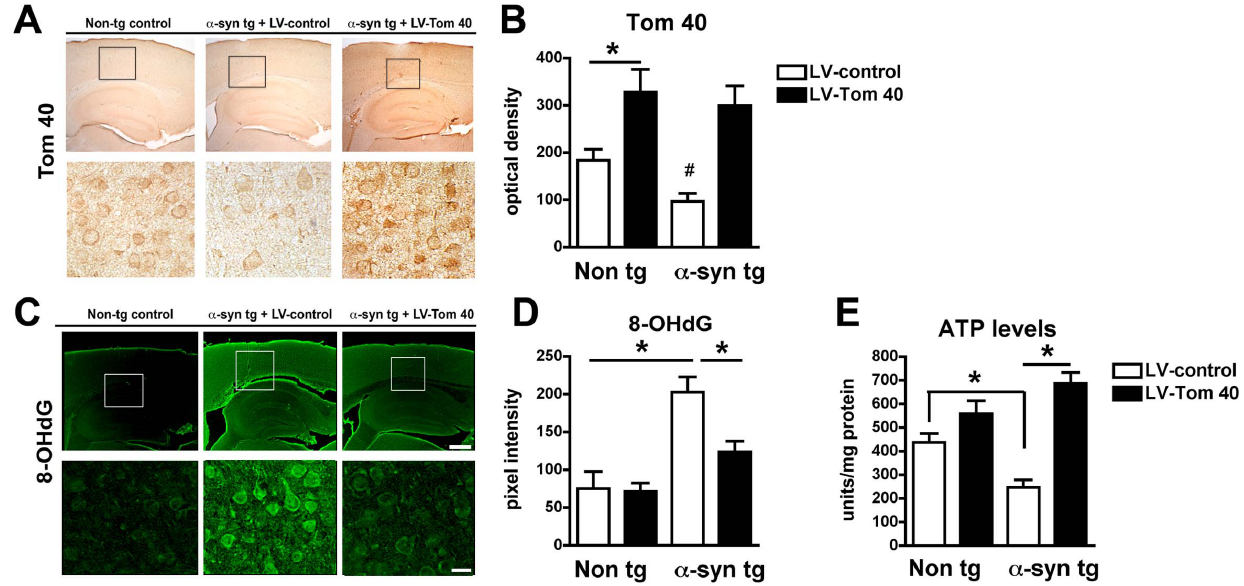
Figure 5. Lentiviral delivery of Tom40 ameliorates a -Syn-induced mitochondrial alterations in transgenic mice. (A) Tom40 immunostaining in sagittal brain sections at the level of the hippocampus of non-transgenic (non-tg) controls and a -Syn-tg mice injected with control lentivirus (LV-control) or with lentiviral delivery of Tom40. (B) Stereological analysis of Tom40 immunoreactivity (optical density) showing increased signal after LV-Tom40 treatment. (C) Fluorescent immunolabeling of oxidative DNA lesions (anti-8-OHdG) in control and a -Syn tg mice treated with LV-control or LV-Tom40. Scale bar represents 100 m m in the upper panel and 15 m m in the lower panel. (D) Stereological analysis of anti-8-OHdG staining intensity reveals normal oxidative lesion load in tg animals overexpressing Tom40. ( E ) Quantification of ATP levels on brain homogenates from mice treated with LV-control or LV-Tom40. *p , 0.05 per Student’s t test.